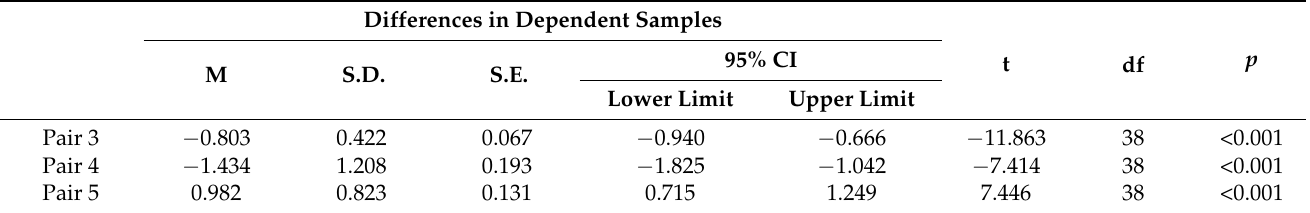
Table 5. Test for dependent